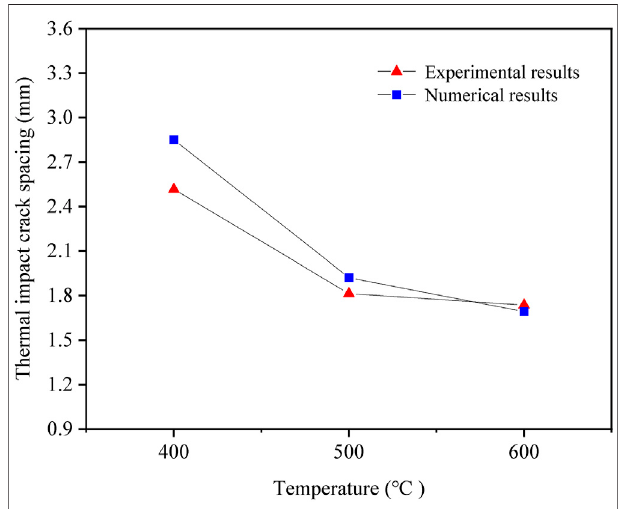
FIGURE 10 | Average crack spacing of rectangular Al 2 O 3 specimens.